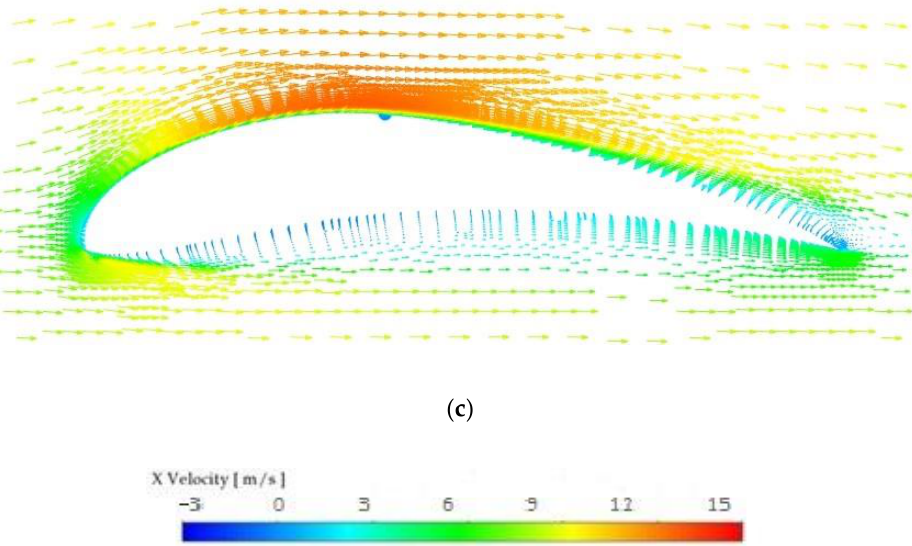
Figure 13. Development of velocity vectors around the airfoils at 25% of the wingspan, 0° AoA and Re = 86,000 of the ( a ) original wing, ( b ) wing with bumps, and ( c ) wing with dimples.